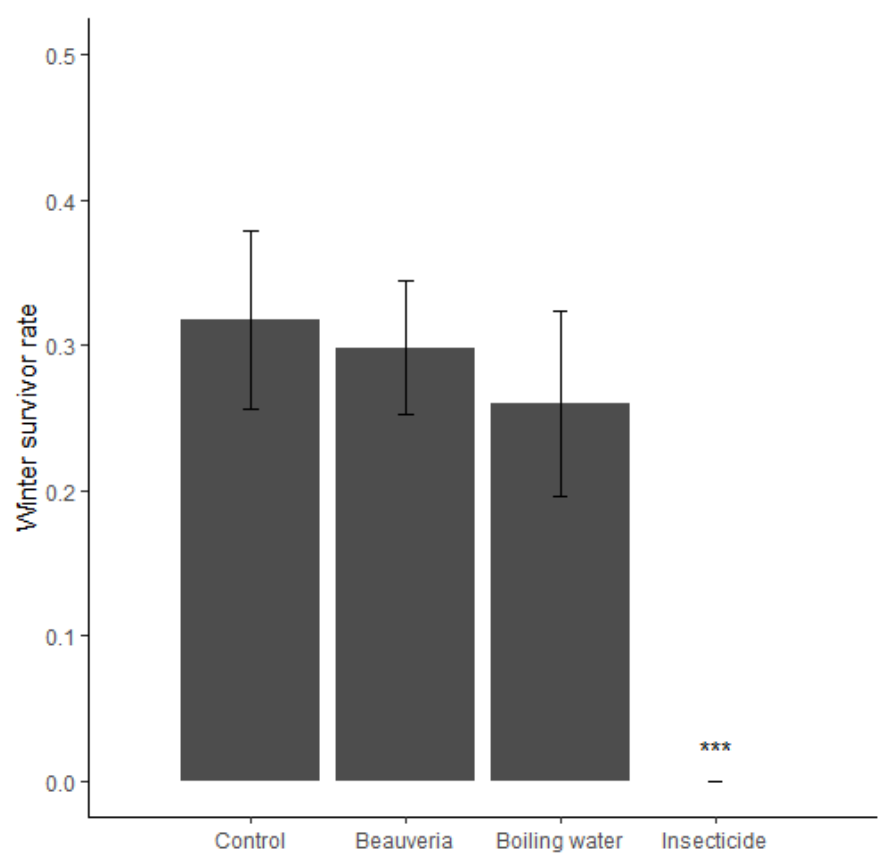
Figure 4. Winter survivorship rate of the tarnished plant bugs (calculated as proportion of surviving bugs on the number of introduced individuals) as a function of the repressive treatment. Error bars correspond to 95% confidence intervals. The “***” indicates that the treatment is statistically different than the other treatments.